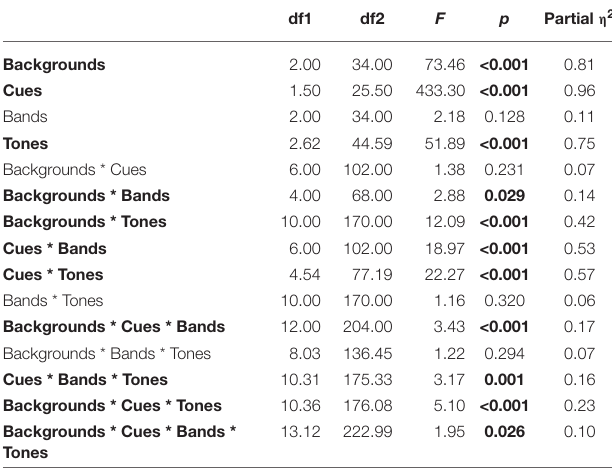
TABLE 2 | Results of Backgrounds * Cues * Bands * Tones four-way repeated measures ANOVA on tone accuracy. df1